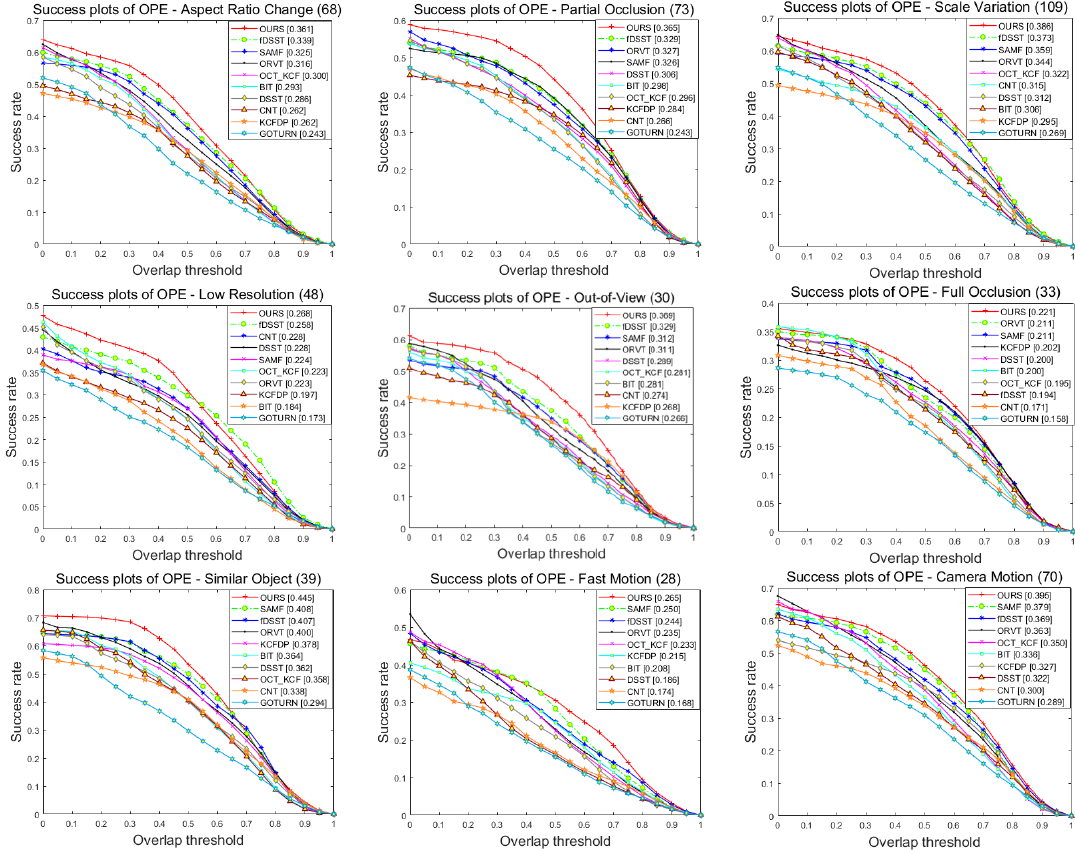
Figure 5. Success ( left ) and precision ( right ) plots of proposed tracker compared with state-of-the-art approaches on UAV123